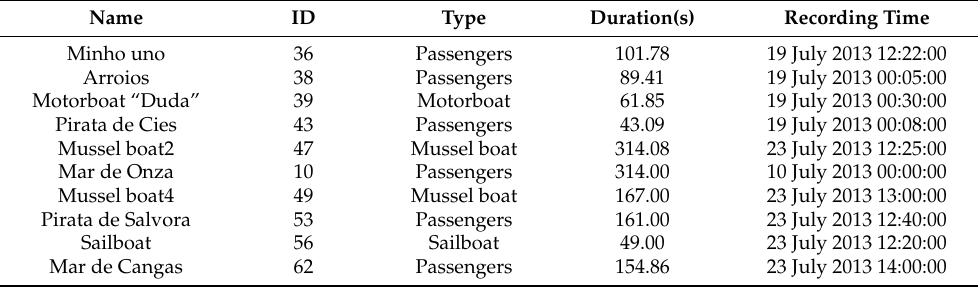
Table 1. Overall summary of the selected